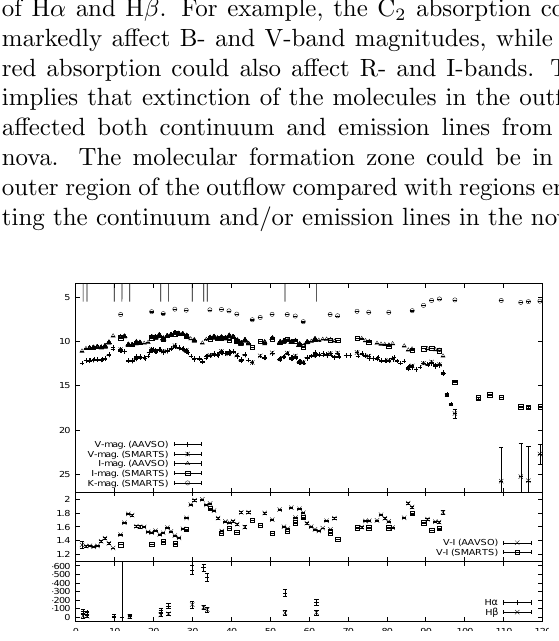
from AAVSO and SMARTS), color indices ( V − I ) based on the AAVSO and SMARTS database, and equivalent widths of H α and H β measured in our spectra. Upper tick marks indicate days on which spectroscopic obser- vations were